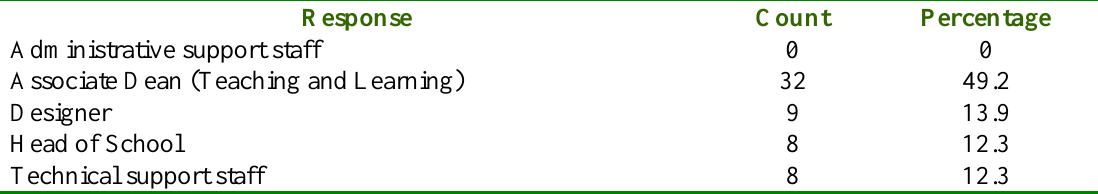
Table 4. Groups Responsible for the Quality of CMS Response